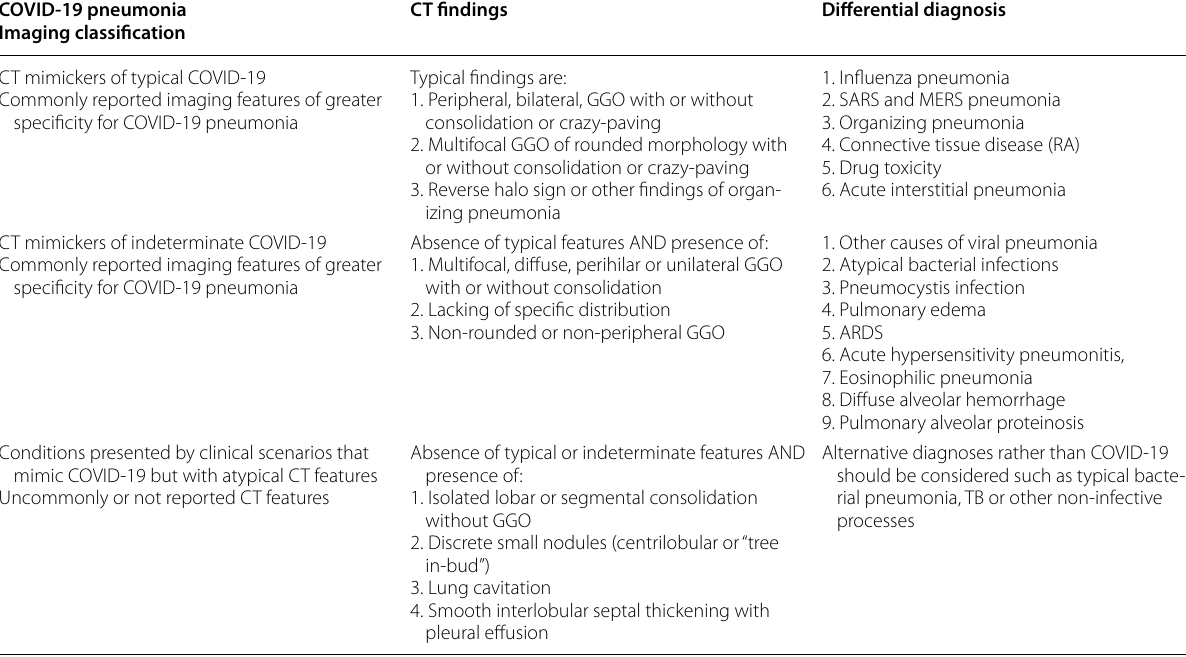
Table 1 Proposed reporting categories for CT findings related to COVID‑19